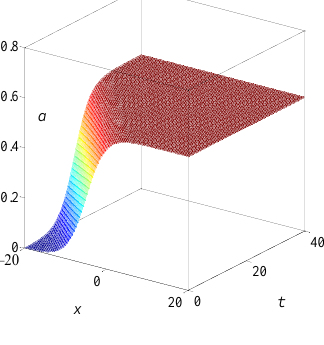
(𝜉) = 2√2𝑘 − 2√2𝑟𝑘 𝑢 81